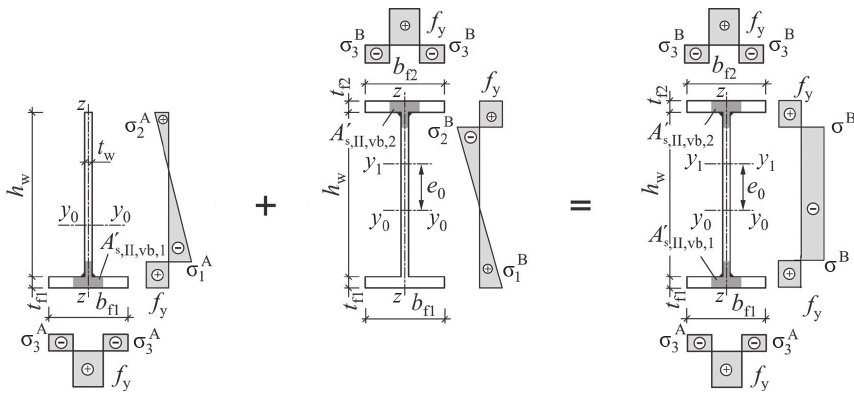
Fig. 9. Procedure of calculation of residual stresses for i